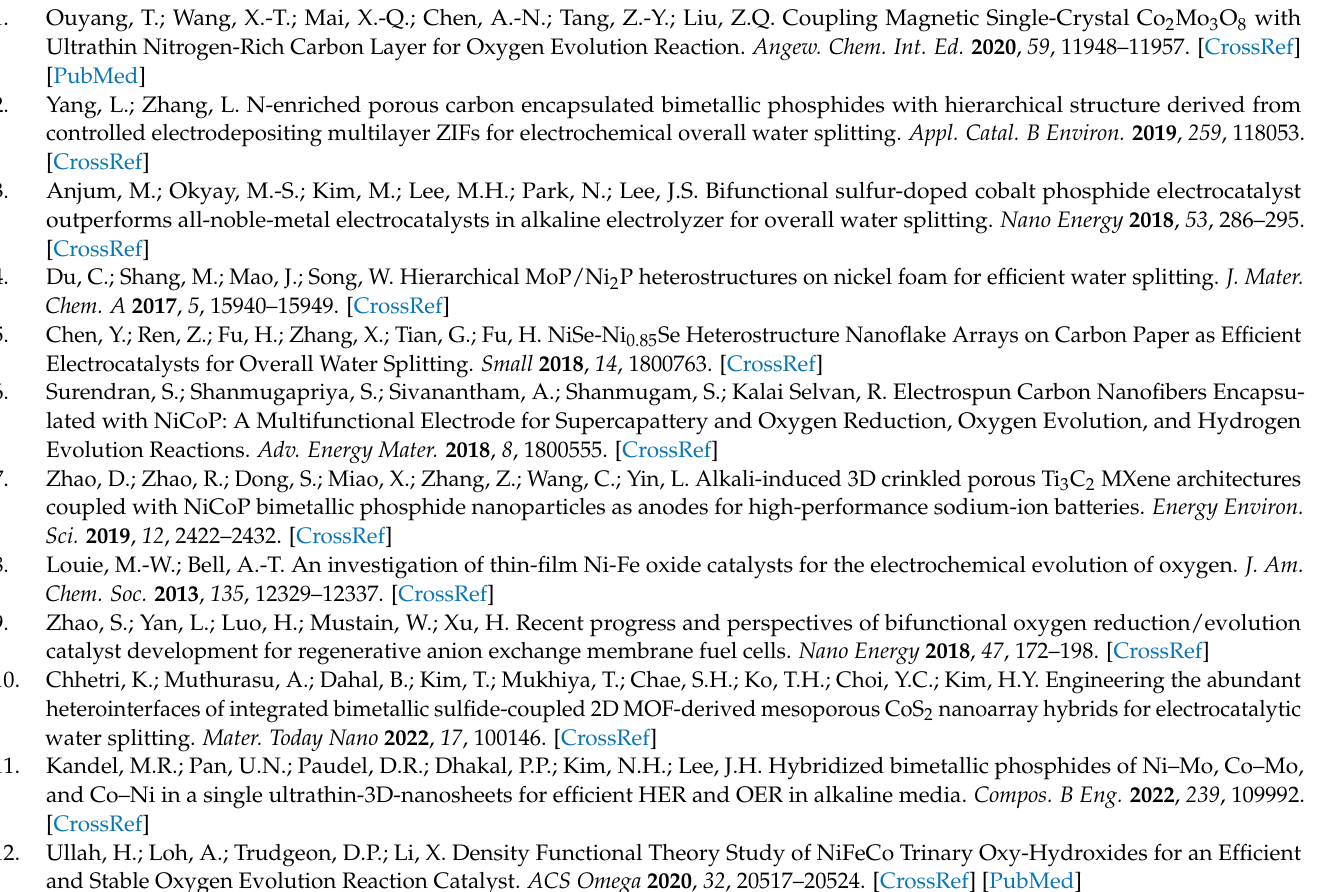
CoP NFs, and CoMoO 4 NFs at current densities of 50 mA cm − 2 and 100 mA cm − 2 for OER test; Figure S4 Cyclic voltammograms of (a) CoMoP NFs, (b) CoP NFs, and (c) CoMoO 4 NFs with a potential range from − 0.2–0.6 V (V vs. RHE) in 1M PBS solution; Figure S5. Cyclic voltammograms of (a) CoMoP NFs, (b) CoP NFs, and (c) CoMoO 4 NFs in a potential range from 0.2–0.3 V (V vs. SCE) in 1 M